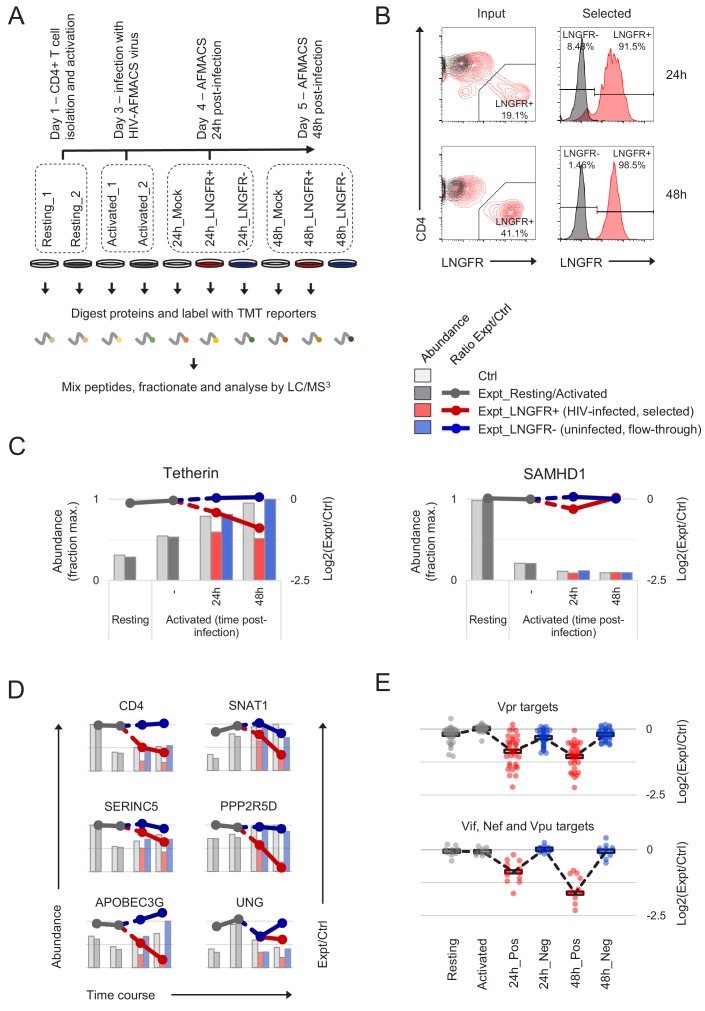
Temporal proteomic analysis of HIV infection in primary T cells.(A) Overview of time course proteomic experiment. Control (pale grey, resting/activated/mock) and experimental (dark grey, resting/activated; red, LNGFR+, HIV-infected, selected; blue, LNGFR-, uninfected, flow-through) cells are indicated for each condition/time point. (B) Magnetic sorting of HIV-infected (red, LNGFR+, selected) cells used for (A). Corresponding uninfected (LNGFR-, flow-through) cells are shown in Figure 2—figure supplement 1A. Cells were separated using AFMACS at the indicated time points post-infection with HIV-AFMACS, stained with anti-LNGFR and anti-CD4 antibodies and analysed by flow cytometry. Mock-infected cells are shown in grey. (C) Expression profiles of illustrative restriction factors regulated by T cell activation and HIV infection (tetherin) or T cell activation alone (SAMHD1) in cells from (A–B). Relative abundances (bars, fraction of maximum) and log2(ratio)s of abundances (lines) in experimental (Expt):control (Ctrl) cells are shown for each condition/time point and coloured as in (A) (summarised in the key). (D) Expression profiles of illustrative accessory protein targets (CD4, Nef/Vpu; SERINC5, Nef; SNAT1, Vpu; APOBEC3G, Vif; PPP2R5D, Vif; UNG, Vpr) in cells from (A–B). Axes, scales and colours are as in (C). Expression profiles of other accessory protein targets are shown in Figure 2—figure supplement 1B. (E) Patterns of temporal regulation of Vpr vs other accessory protein (Vif/Nef/Vpu) targets in cells from (A–B). Log2(ratio)s of abundances in experimental (Expt):control (Ctrl) cells are shown for 45 accessory protein targets (as in Figure 2—figure supplement 3A). Colours are as in (C), and average profiles (mean, black lozenges/dotted lines) are highlighted for each group of targets.
10.7554/eLife.41431.006Figure 2—source data 1.Functional proteomic atlas of HIV-infection in primary human CD4+ T cells.Interactive spreadsheet enabling generation of temporal profiles of protein abundance for any quantitated genes of interest (‘Gene search and plots’ worksheet). Time course data (cells from Figure 2A) are presented as in Figure 2C, with relative protein abundances (fraction of maximum) for each condition depicted by bars, and log2(ratio)s of protein abundances in paired experimental/control cells from each condition/time point depicted by lines (grey, resting/activated; red, LNGFR+, infected; blue, LNGFR-, uninfected). Single time point data (cells from Figure 3A) are presented as in Figure 3D, with relative protein abundances (fraction of maximum, mean plus 95% CIs) for each condition depicted by bars (grey, mock; red, WT HIV; green, ΔVif HIV). The number of unique peptides is shown for each protein/experiment, with most confidence reserved for proteins with values > 1. For the single time point experiment, p values (unadjusted) and q values (Benjamini-Hochberg FDR-adjusted) are shown (highlighted in gold if <0.05). Complete (unfiltered) proteomic datasets (‘Time course dataset’ and ‘Single time point dataset’ worksheets) are also included.